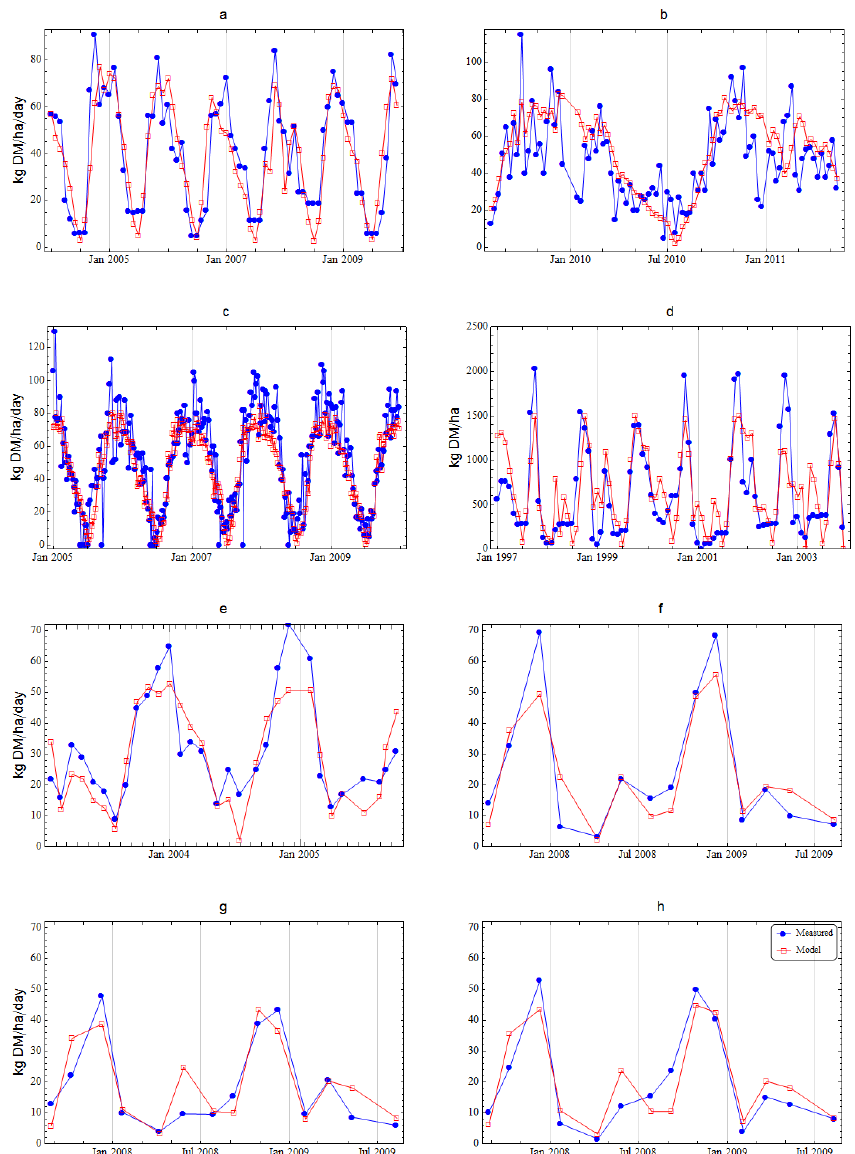
Figure 2. Modelled and measured pasture growth at calibration sites. Growth (in average kilograms of dry matter per hectare per day) versus time at all dairy (a – c) and sheep/beef (d – h) calibration sites: (a) Waitepeka Dairy Farm (Southland) from January 2004 to December 2009; (b) Scott Dairy Farm (Hamilton) from August 2009 to May 2011; (c) Lincoln University Dairy Farm (Canterbury) from January 2005 to December 2009; (d) Winchmore Research Station (Canterbury) from January 1997 to December 2003 (in total kilograms of dry matter per hectare rather than daily averages); (e) Whatawhata (Waikato) from February 2003 to October 2005; (f) Te Whanga (Wairarapa) uneroded site, (g) Te Whanga 1977 slip site, and (h) Te Whanga 1961 slip site, from August 2007 to August 2009. Table 2. Comparison of baseline and intensification Biome-BGC model parameters. Parameter Baseline sheep/beef Intense sheep/beef Baseline dairy Intense dairy Pasture utilisation